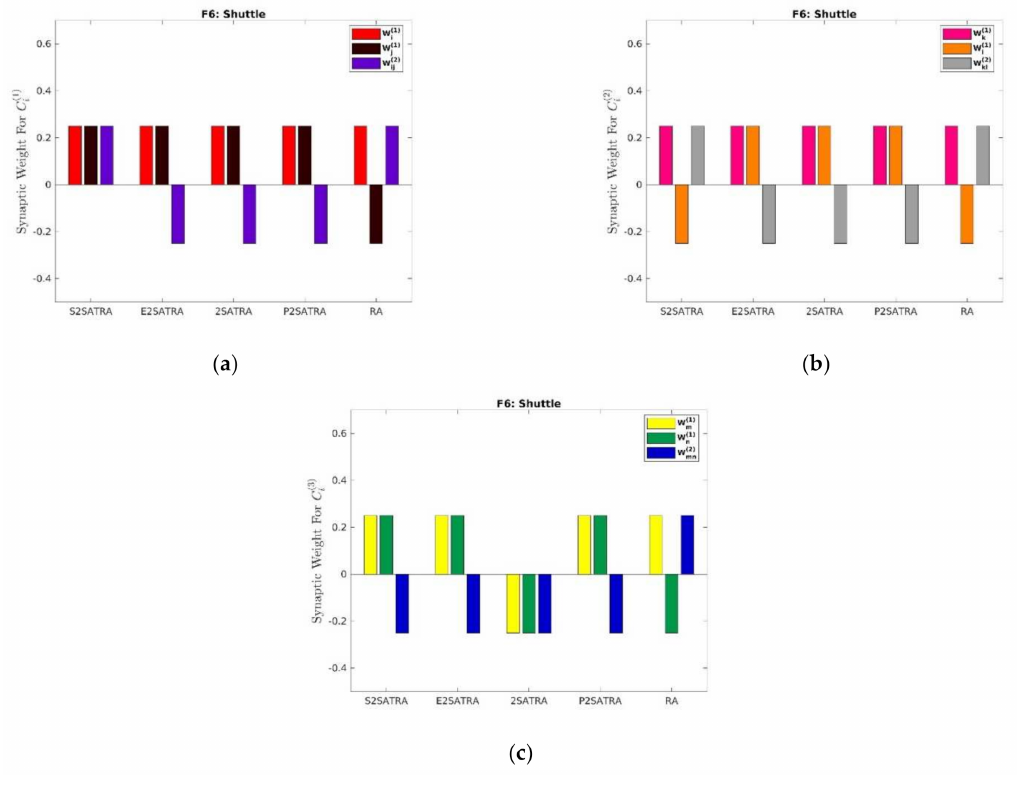
( 1 ) ( 2 ) ; ( b ) C and ( c ) C i i